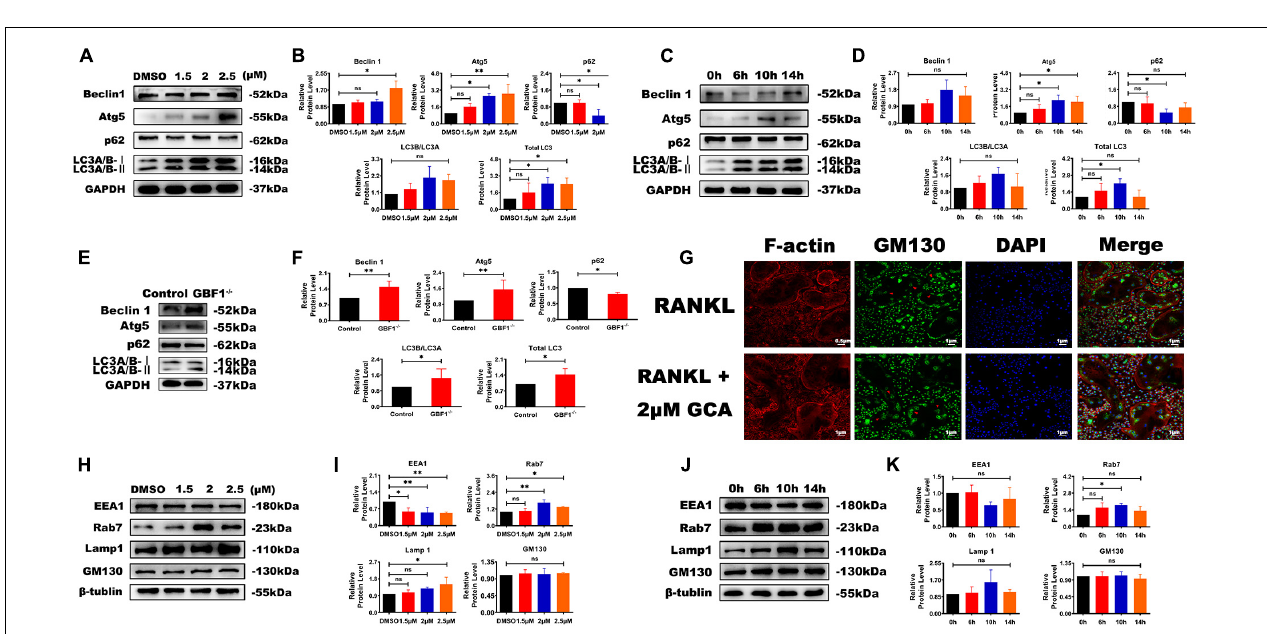
FIGURE 5 | Decrease of GBF1 further caused cell autophagy and affected endosome maturation. (A–F) Western blot analysis of autophagy-related protein in RANKL-induced osteoclasts after GCA treatment (0, 1.5, 2, and 2.5 µ M) and at different time points (0, 6, 10, and 14 h) treated with 2 µ M GCA or with siRNA. (G) Immunostaining of actin rings, GM130 antibody, and nuclei in osteoclasts treated with 2 µ M of GCA for 1–2 days (original magnification, × 20). The red arrows represent the perinuclear Golgi apparatus. (H–K) Western blot analysis of endosome-related protein in RANKL-induced osteoclasts after GCA treatment (0, 1.5, 2, and 2.5 µ M) and at different time points (0, 6, 10, and 14 h) treated with 2 µ M GCA. Data are expressed as mean ± SD of three independent experiments. ∗ p < 0.05; ∗∗ p < 0.01; ∗∗∗ p <